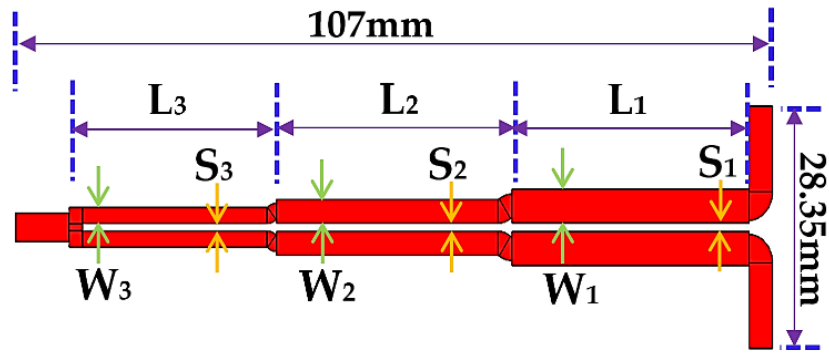
Figure 9. WPD EM modeling using ADS momentum.